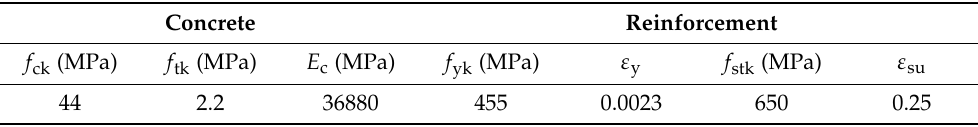
Figure 4. Specimen SB1 (dimensions in mm). Table 2. Material Properties of Specimen SB1. Concrete